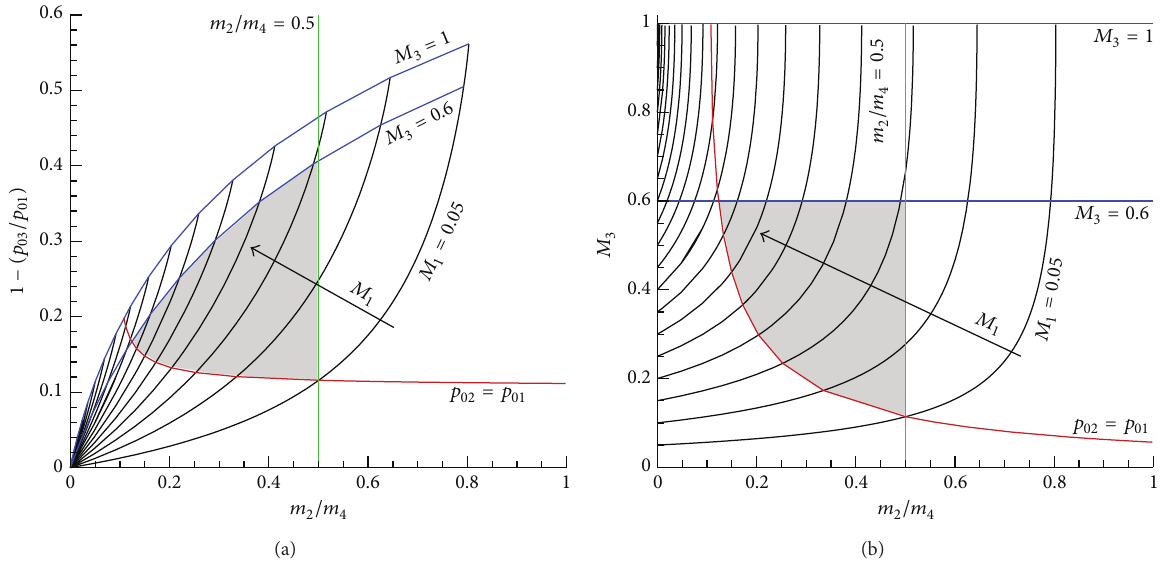
Figure 7: Variation of (a) total pressure loss and (b) exit Mach number ( 𝑀 4 ) as a function of mass flow ratio 𝑚 2 / 𝑚 4 for different values of inlet Mach number ( 𝑀 1 ) with 𝛿 M 1 = 0.05 obtained by inviscid analysis. The calculations were done for 𝐷 0 = 102 mm, four jets with d 7.5 mm.